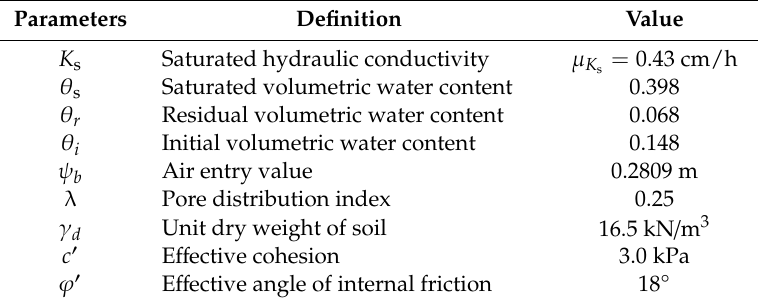
Table 2. Parameters for the study